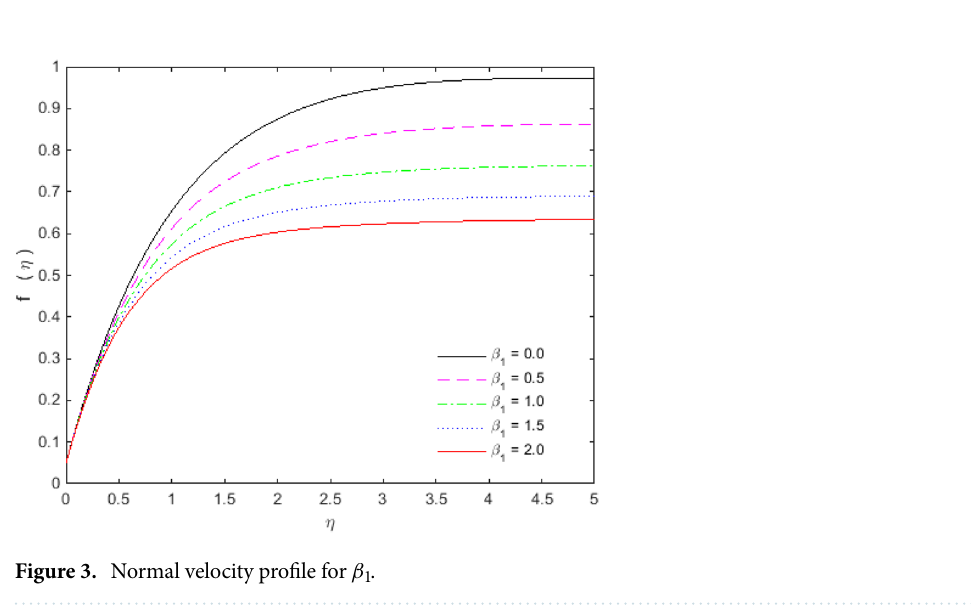
Figure 2. Comparison between numerical and analytical solutions.